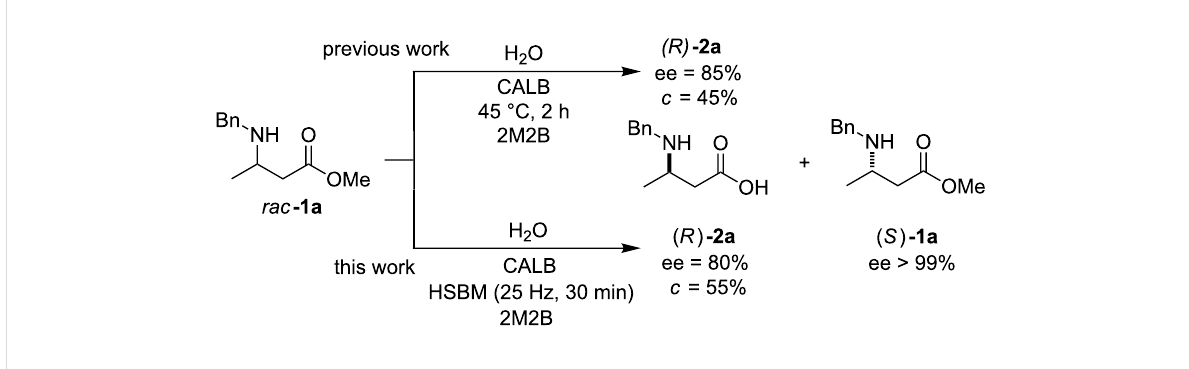
Scheme 1: Enantioselective enzymatic hydrolysis of racemic β 3 -amino ester rac -1a using CALB in solution [52] (top) and under HSBM conditions (button). 2M2B: